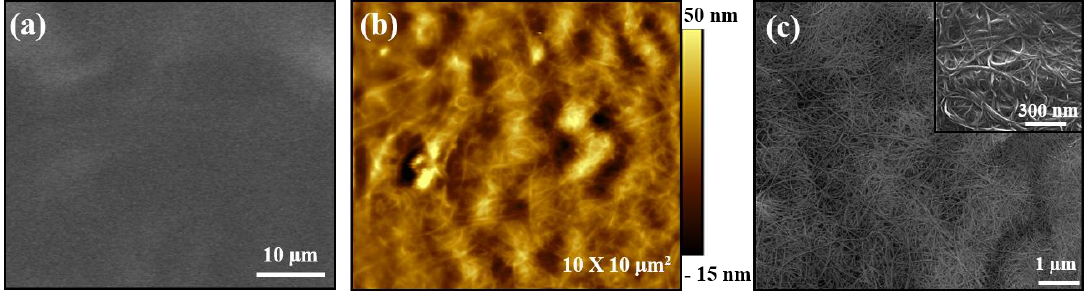
Figure 4. ( a ) SEM image of two bilayer PEO/PAA and ( b ) AFM and ( c ) SEM images of two bilayer PEO / DWNT-PAA assemblies. The inset in the SEM image of two PEO / DWNT-PAA BL films shows the PEO/DWNT-PAA assemblies. The inset in the SEM image of two PEO/DWNT-PAA BL films shows higher resolution of the higher resolution of DWNT.